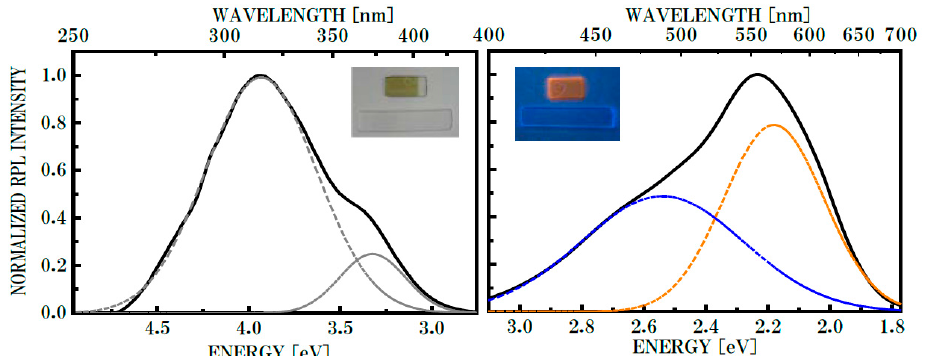
Figure 1. Typical RPL excitation ( left ) and emission ( right ) spectra of X-ray-irradiated Ag + -doped phosphate glass using a fluorescent spectrometer (Hitachi F-2010). The inset of the left figure shows dark colored glass due to absorption band in visible wavelength and the right shows RPL emission when the glass was excited with 365 nm light.